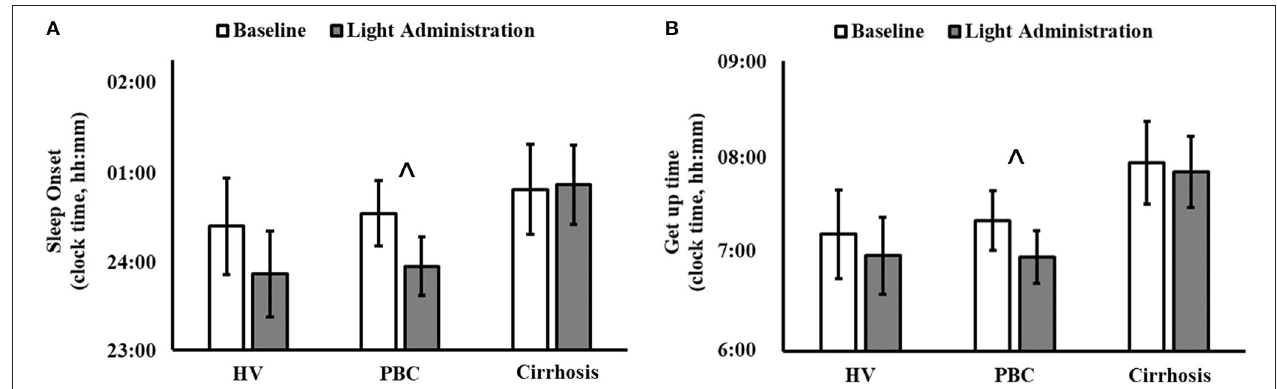
FIGURE 2 | Sleep diary-based sleep onset (clock time; A ) and get up time (clock time; B ) before (white columns) and during light administration (gray columns), by patient category (HV, healthy volunteers; PBC, Primary Biliary Cholangitis). (A) Patient category: p = 0.500; treatment: p = 0.019; patient category × treatment: p = 0.140; ∧ post-hoc significant for PBC: p = 0.047. (B) Patient category: p = 0.270; treatment: p = 0.010; patient category × treatment: p = 0.330; ∧ post-hoc significant for PBC: p = 0.026.